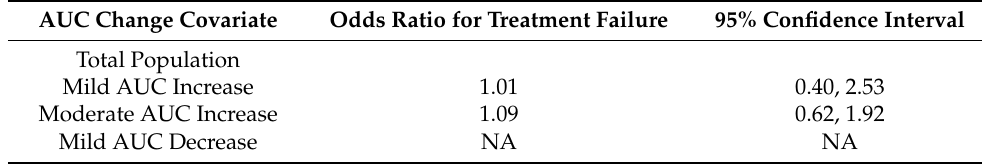
Table 6. Summary of the calculated odds ratios and 95% confidence intervals for risk of treatment failure in the bacteria-specific CAP analysis with respect to AUC change versus no AUC change due to